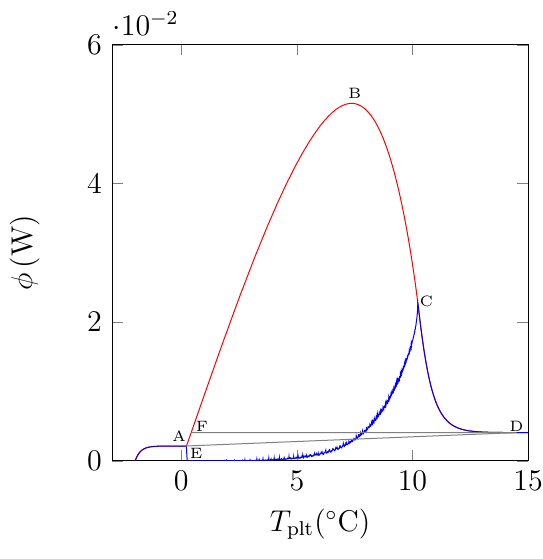
Figure 15. Thermogram(red) and Γ ( T plt ) curve (blue) for